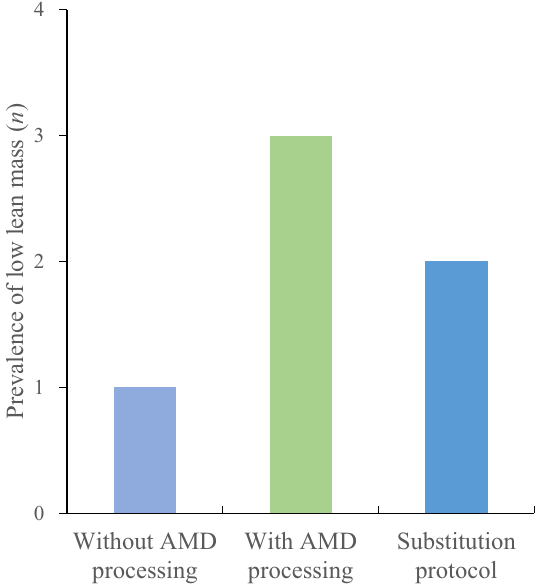
Figure 3. The number of participants with low lean mass (without and with AMD processing) according to the AWGS 2019 guidelines (men, < 7.0 kg/m 2 ; women, < 5.4 kg/m 2 ) among the 10 participants who underwent unilateral total knee replacement surgery. AMD automatic metal detection, AWGS Asian Working Group for